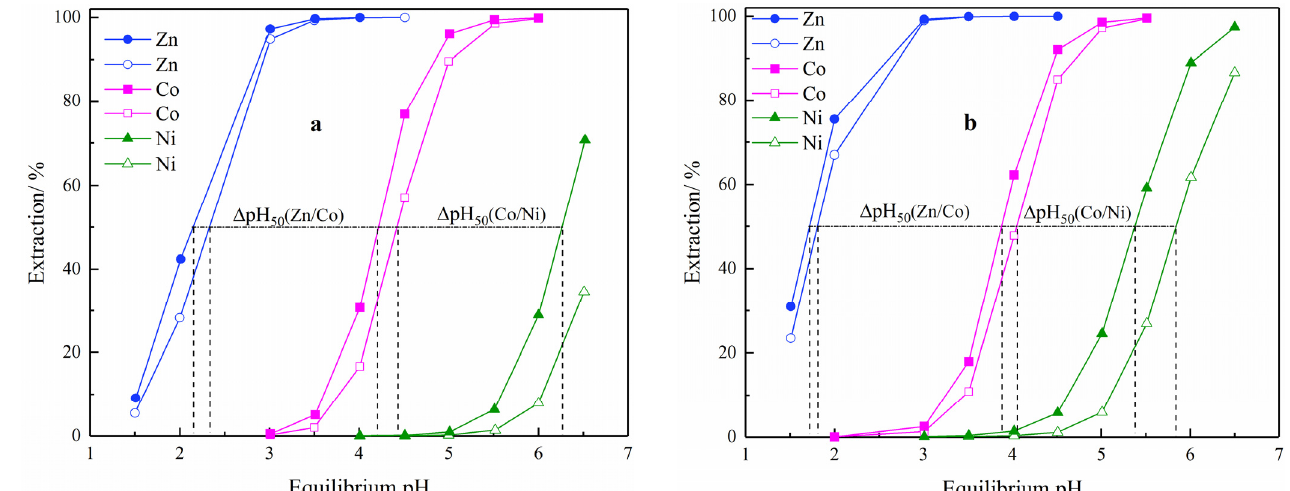
Figure 1. Metal extraction pH isotherm of Cyanex 272 ( a ) and Ionquest 801 ( b ) at an A/O ratio of 1:1 and 40 ◦ C (Organic concentrations: solid-label curve, 0.3 M, and open-label curve, 0.2